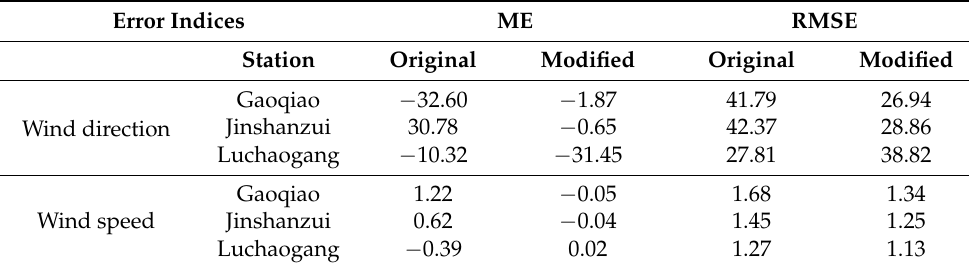
Table 3. Comparison of wind direction and speed errors of each station before and after correction. Error indices